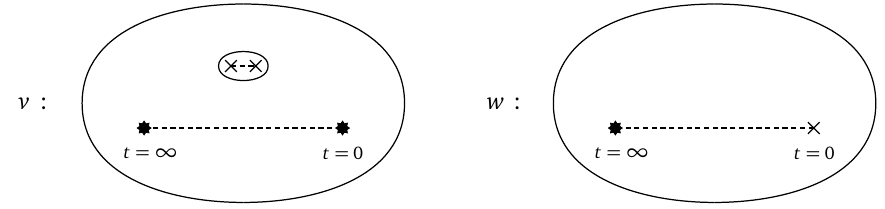
Figure 5: A possible movement and collision of branch points that ensures that the branch structures of v and w curves coincide. This configuration gives rise to a con- sistent N = 1